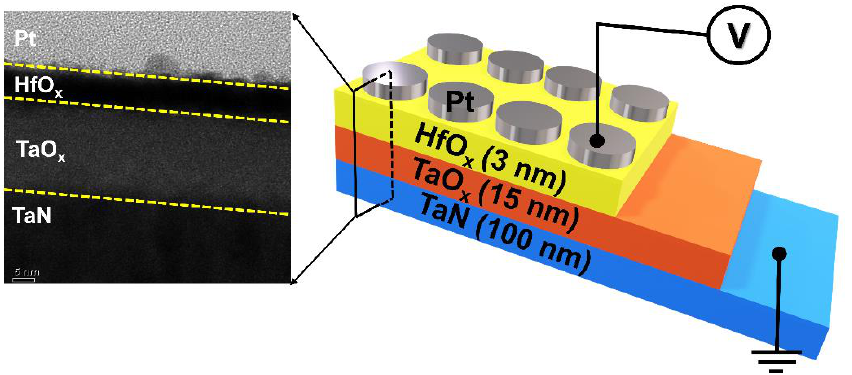
Figure 1. Cross-sectional TEM analysis and schematic of the Pt/HfO 2 /TaO x /TaN (PHTT3) device.